Question: Name the type of graph shown.
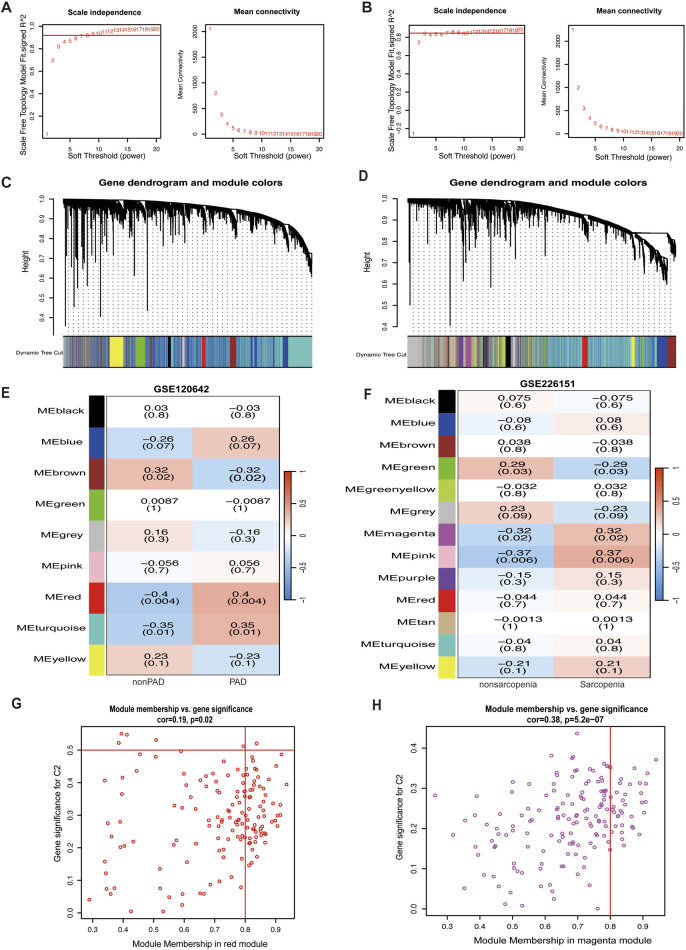
Answer: heatmap